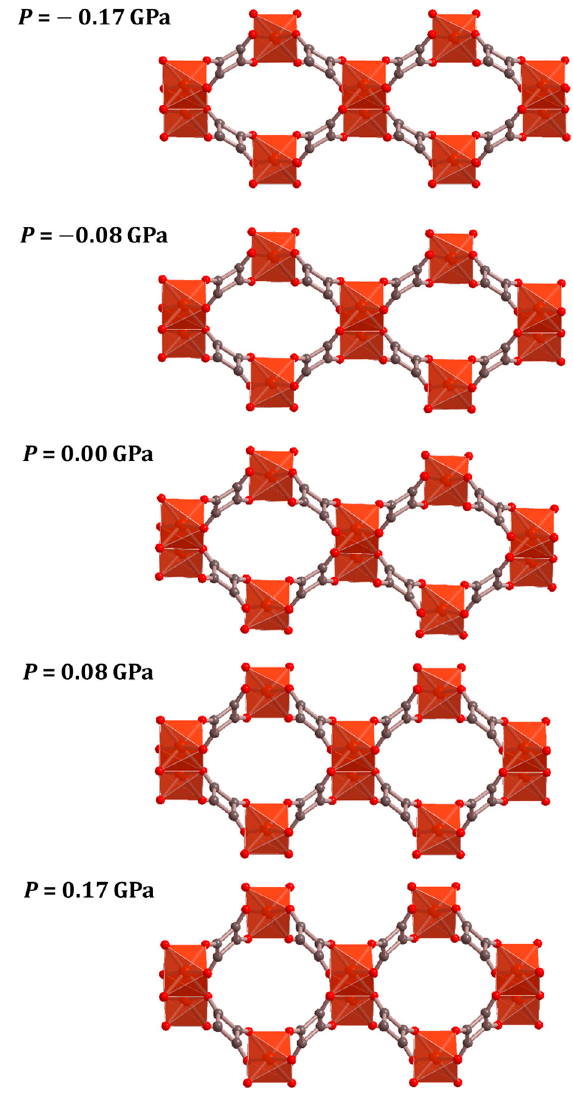
Figure 8. The structure of copper squarate under different stresses applied along [1 0 0] direction. View of a 2 × 1 × 1 supercell showing two structural channels at different stresses: P = − 0.17, –0.08, 0.0, 0.08 and 0.17 GPa.